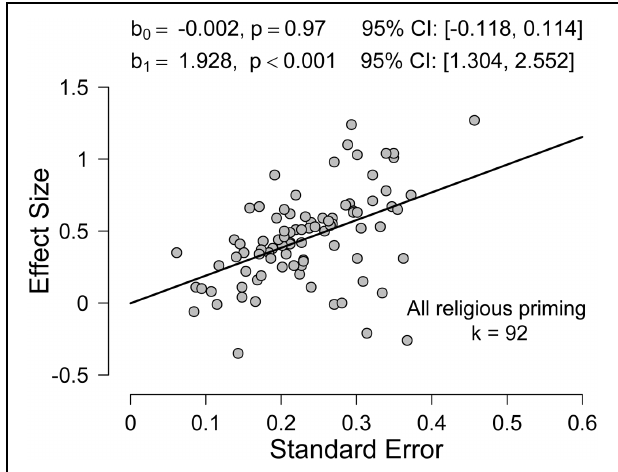
FIGURE 1 | Fit of the Precision-Effect Testing (PET) model to all religious priming studies ( k = 92) in the meta-analysis by Shariff et al.